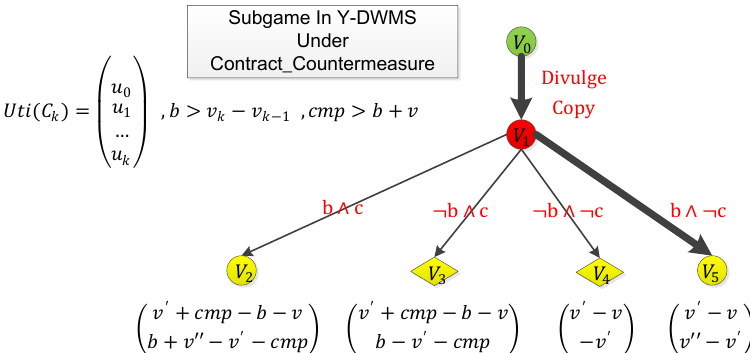
Figure 7. The subgame mentioned above will be changed like this under Contract_Countermeasure